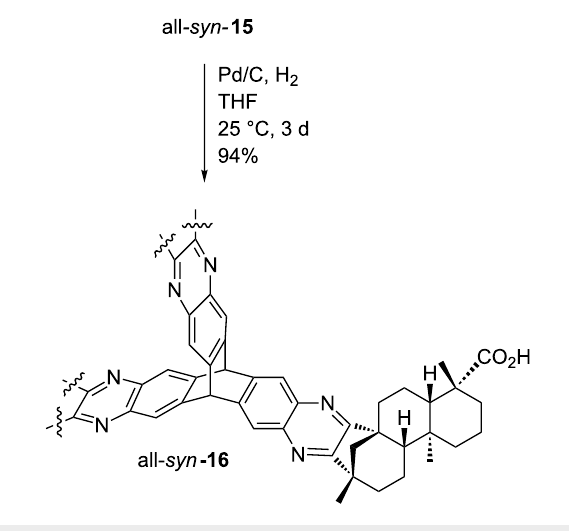
Scheme 6: Hydrogenolysis to tricarboxylic acid all- syn- 16